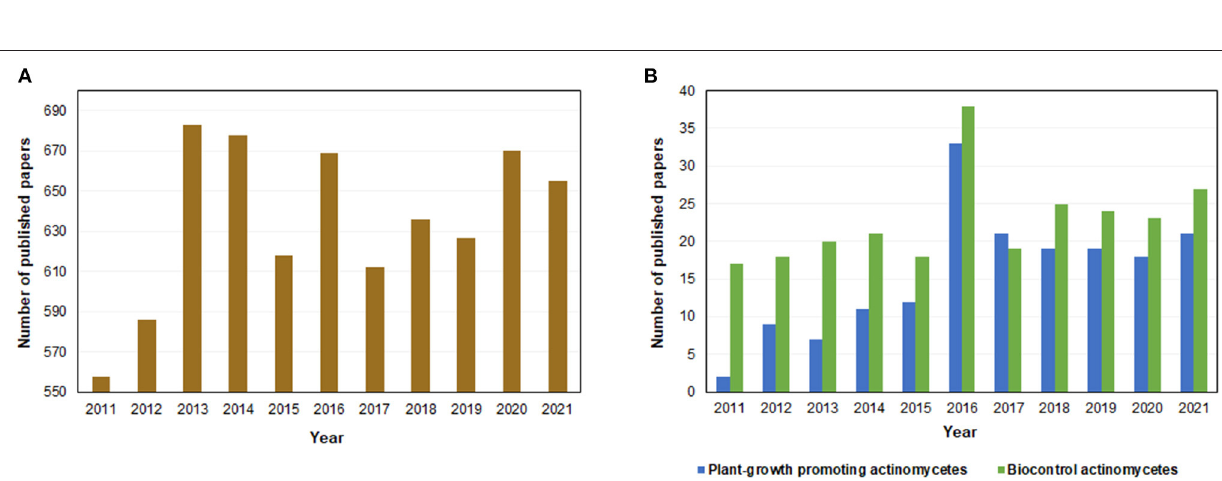
Frontiers in Soil Science | www.frontiersin.org